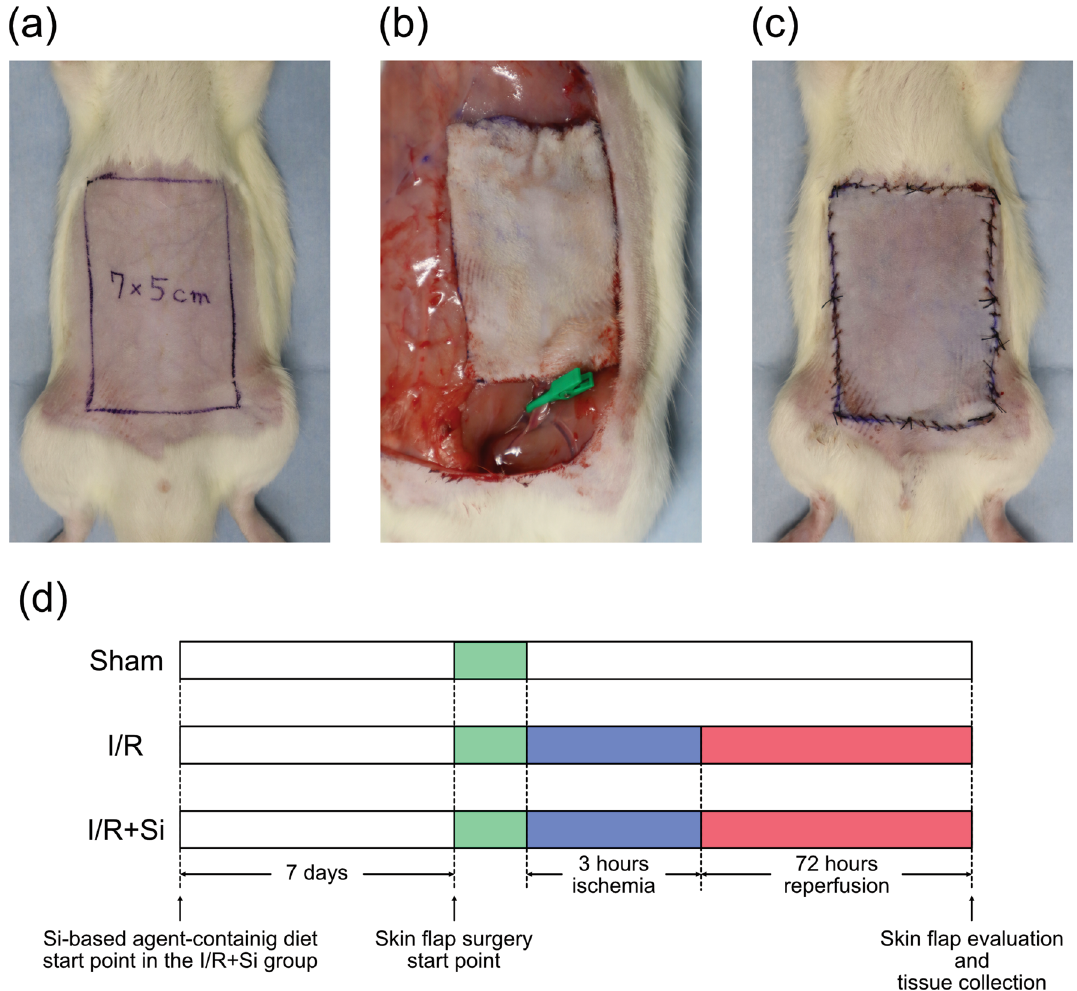
Figure 1. Surgical procedure. ( a ) A 7 × 5 cm rectangular skin flap was designed on the abdomen of the rat. ( b ) The vascular pedicle of the flap was occluded for three hours in the I/R and I/R + Si groups. ( c ) The skin flap was re-sutured in the original position after a silicon sheet was placed between the flap and recipient bed. ( d ) Schematic illustration of the experimental